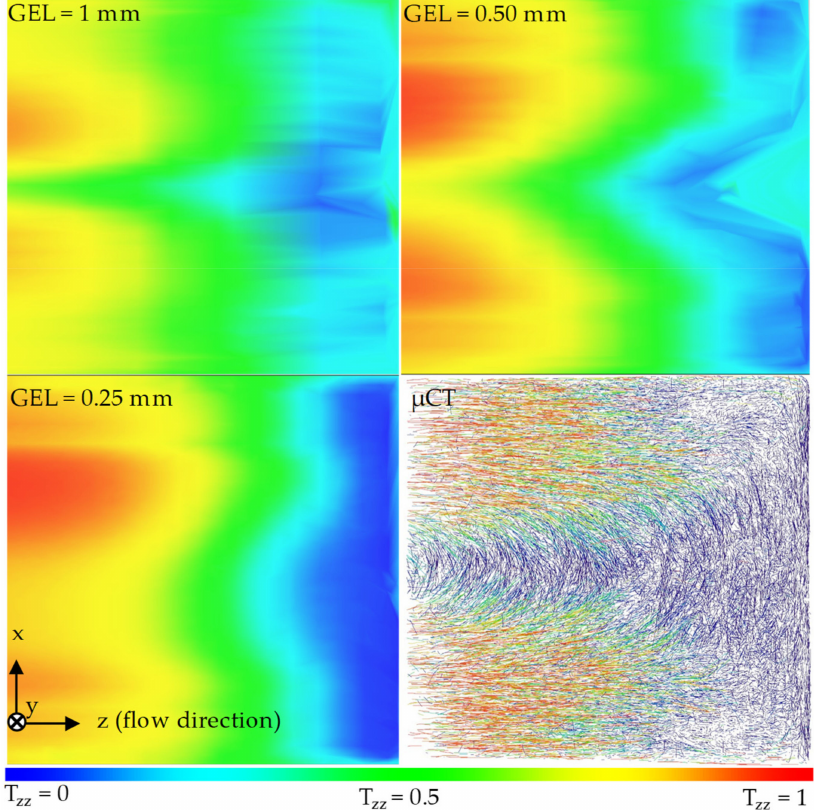
Figure 9. Qualitative comparison between the real fiber orientation characterized by µ CT and the fiber orientation predicted by the 3D mesh in region 2 under variation of the GEL along the XZ